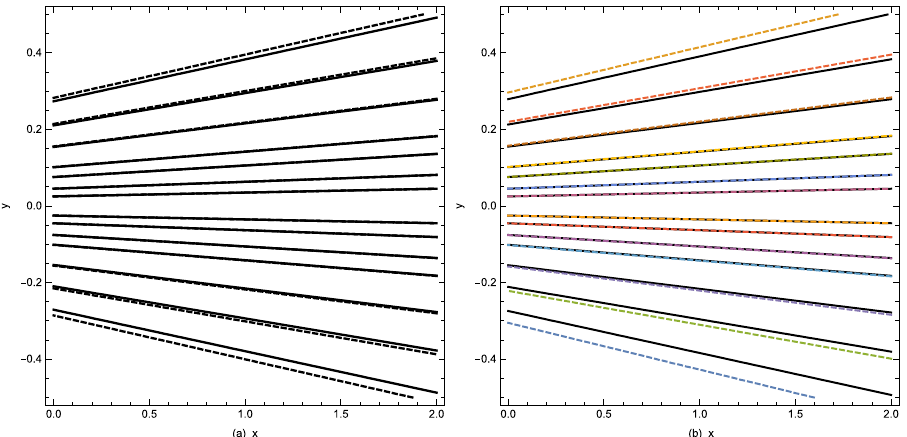
Figure 11. Stream contours are plotted for Gr T = Gr S = 1.5 (solid lines) and Gr T = Gr S = − 1.5 (dotted lines) inside ( a ) converging ( Re = − 5.0 ) ( b ) diverging ( Re = − 5.0 ) channels. While the other parameters are m = 0.2, Pr = 1.0, Sc = 1.0